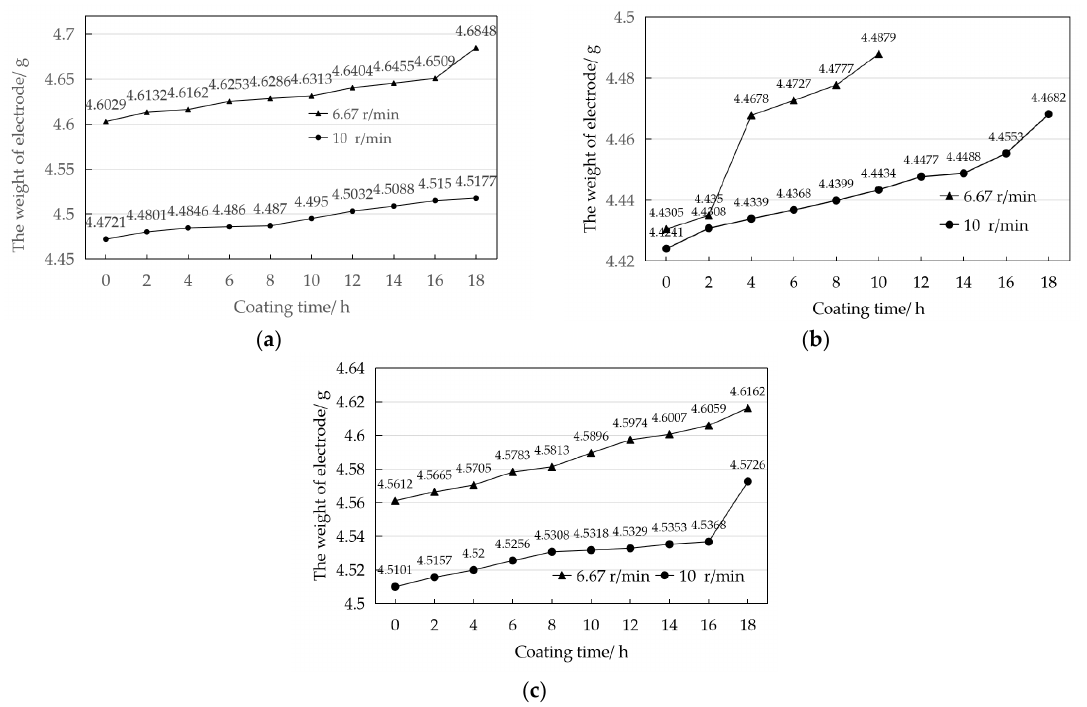
Figure 6. The weight of the electrode in each period under the influence of different coating speeds: ( a ) No. 1 electrode; (b ) No. 2 electrode; ( c ) No. 3 electrode. Table 3. Weight gain per unit time at different coating speeds.